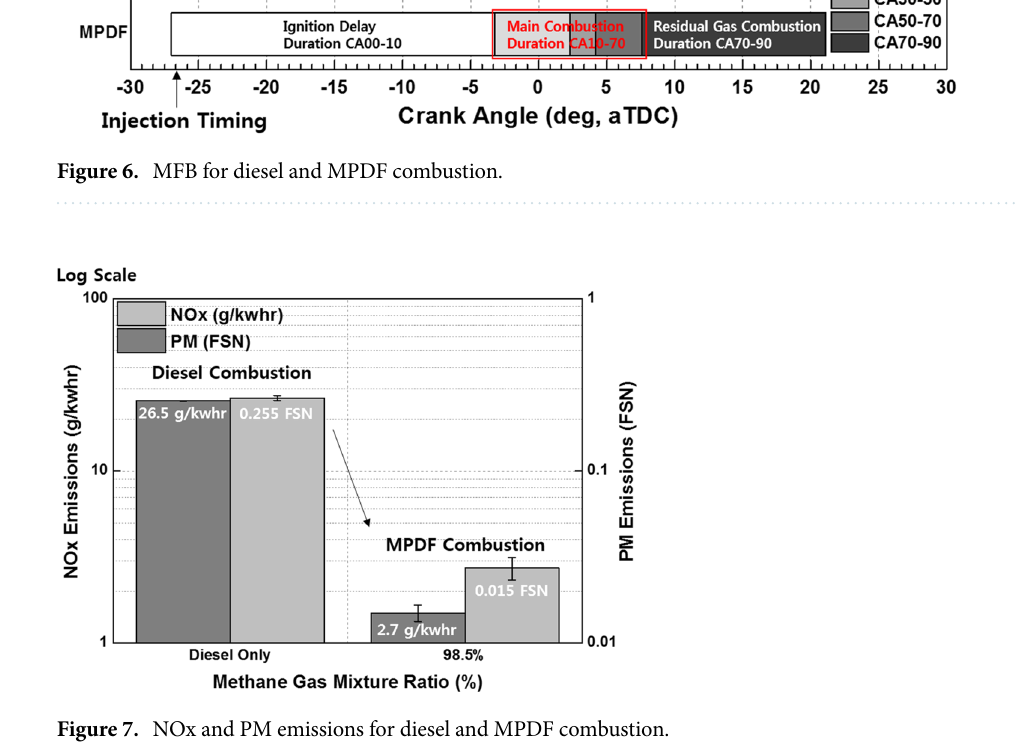
Figure 7. NOx and PM emissions for diesel and MPDF